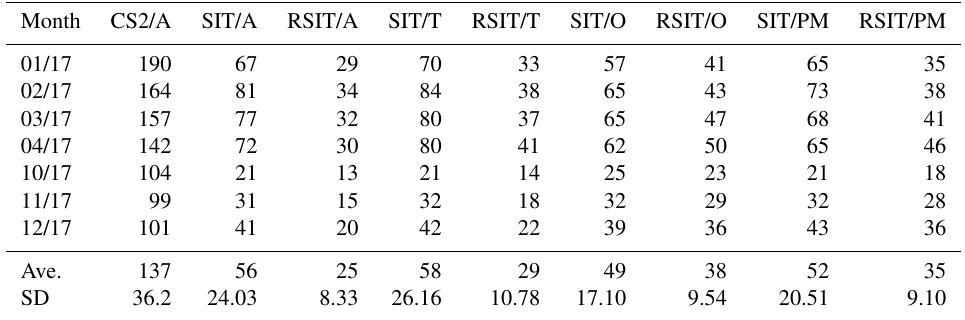
Table 4. Monthly average RMSD in centimetres between the different SIT estimates with respect to the reference SIT data sets. The symbols are the same as in Table 3.